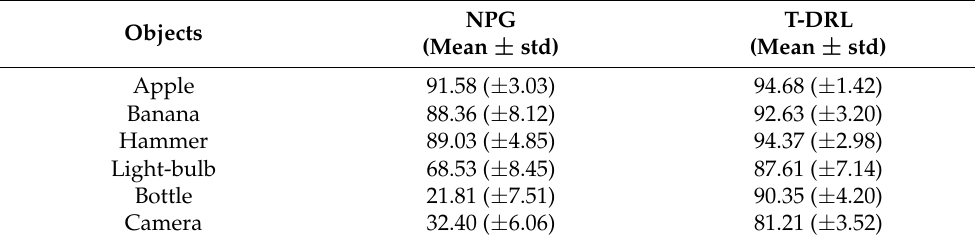
Table 1. Success rate (%) of natural manipulation tasks using NPG and T-DRL. Objects